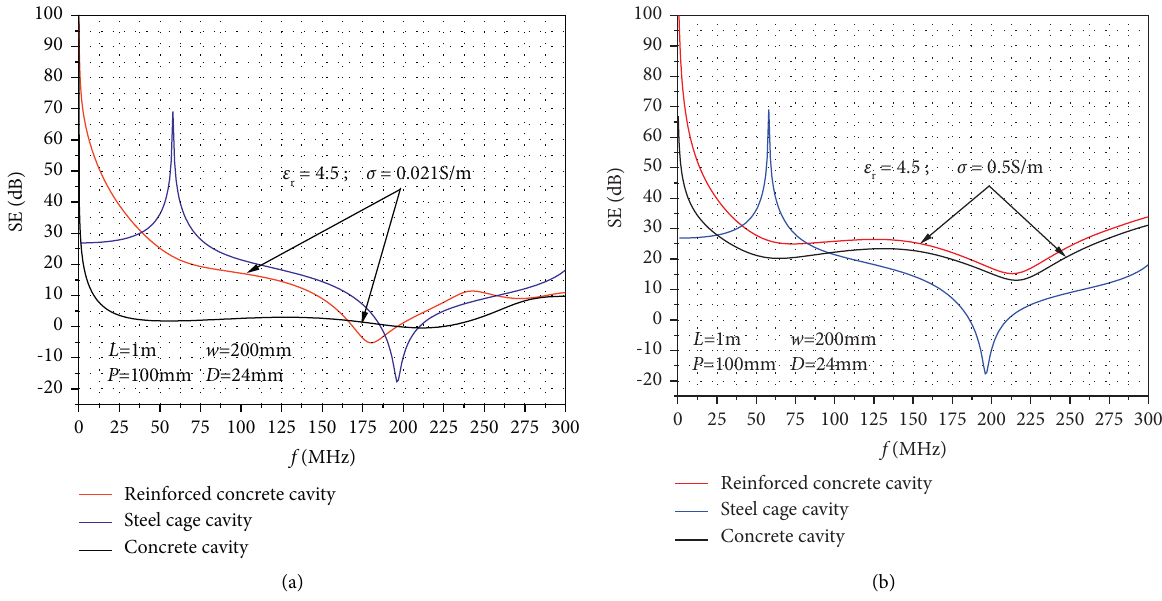
Figure 5: Comparison of shielding efectiveness of three shielding structures under diferent conductivity: (a) σ � 0.021S/m and (b) σ �